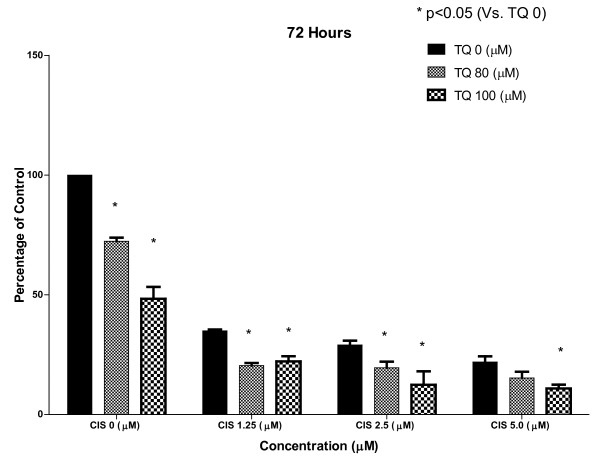
The figure shows results of MTT assay for cell proliferation using NSCLC cell line NCI-H460 at 24, 48 and 72 hrs with control group representing 100% cell proliferation depicted by extreme left solid line. TQ alone is more active at 24 hrs and CDDP more active at 48 and 72 hrs. The combination of TQ and CDDP is more active than each agent alone with up to 89% inhibition of cell proliferation at 72 hrs with combination of TQ 100 μM and CDDP 5 μM. (*) shows significant inhibition by TQ at each level of CDDP (p < 0.05).